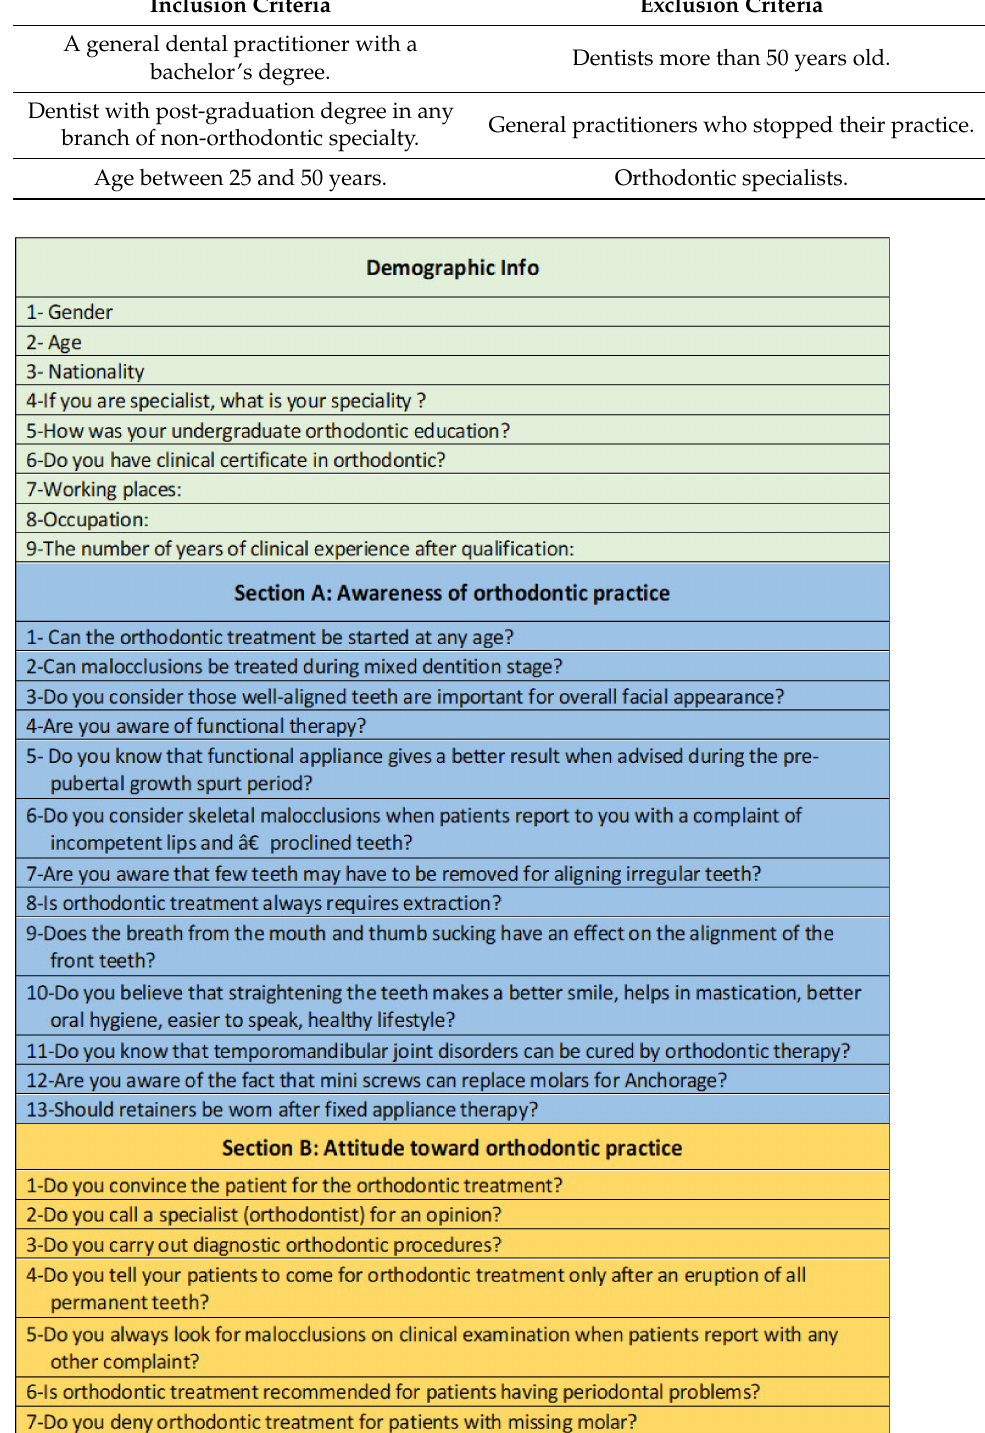
Table 1. Inclusion and exclusion criteria.